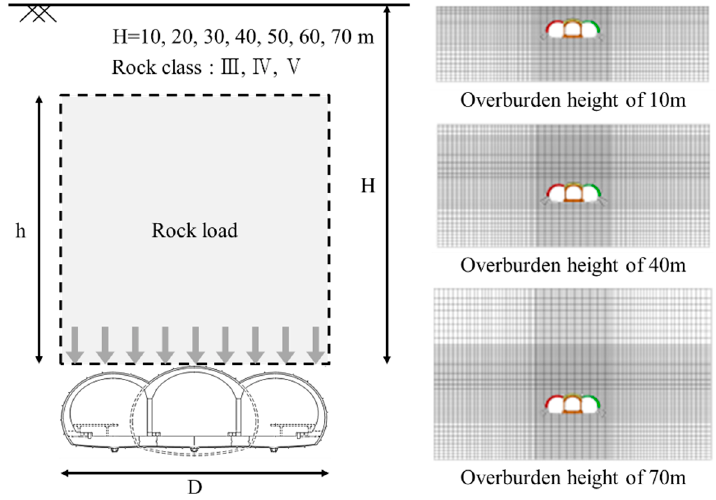
Figure 7. Schematic of the parameters used in this study.